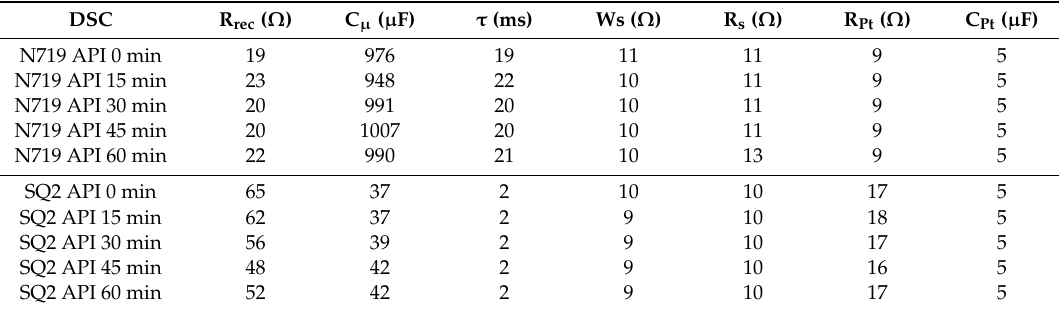
Table 2. The EIS parameters for the DSCs with N719 and SQ2 dyes. The DSCs were measured with DSCs were kept under ambient